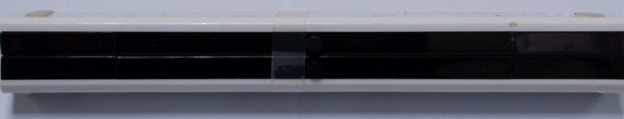
Figure 3. The IR source carried by the